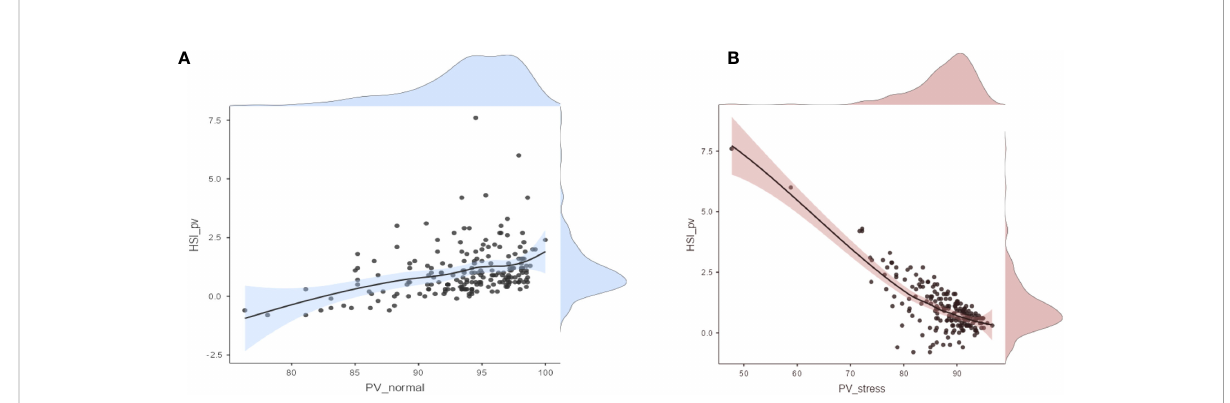
FIGURE 4 (A) Scatter plot between HSI pv and pollen viability under normal conditions (PV_normal). (B) Scatter plot between HSI pv and pollen viability under stress conditions